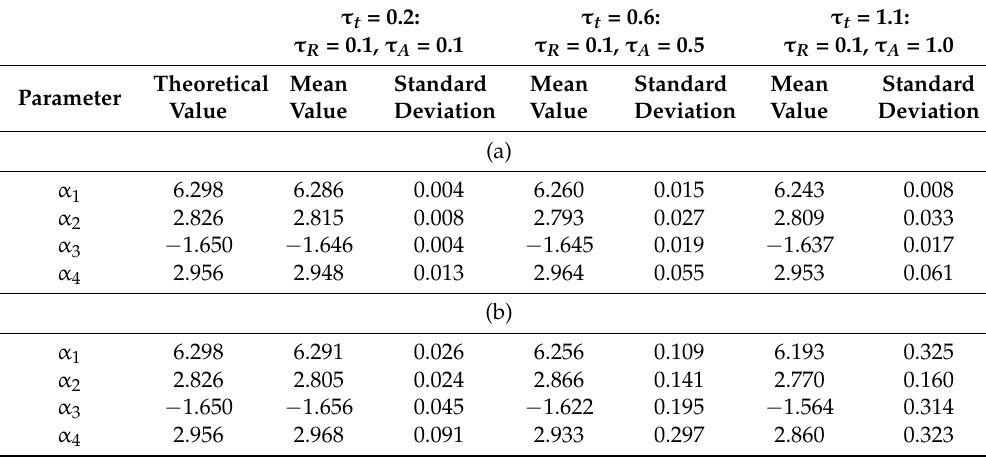
Table 1. Parameters of Nilson–Kuusk BRDF, Equation (13), retrieved from surface radiance using 10 sets of 60 (a), and 10 sets of 12 (b) randomly selected sun-to-sensor geometries for different optical thickness of the atmosphere multiplied by